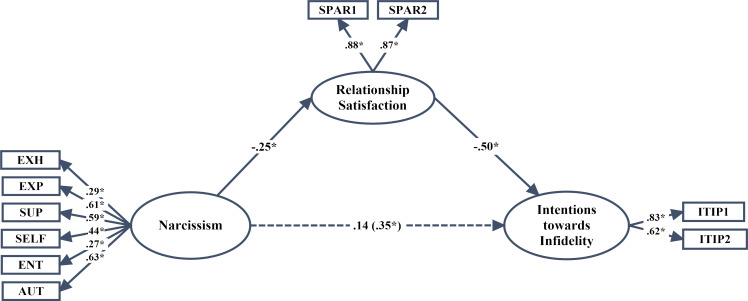
*p < .05, standardized parameter estimates of the final structural model; the parameter value is given in parentheses for when the effect of relationship satisfaction on intentions towards infidelity was fixed to zero; EXH: Exhibitionism; EXP: Exploitation; SUP: Superiority; SELF: Self-sufficiency; ENT: Entitlement; AUT: Authority; ITIP1–2 = two parcels from the Intentions towards Infidelity Scale; SPAR1–2 = two parcels from the Relationship Satisfaction Scale.